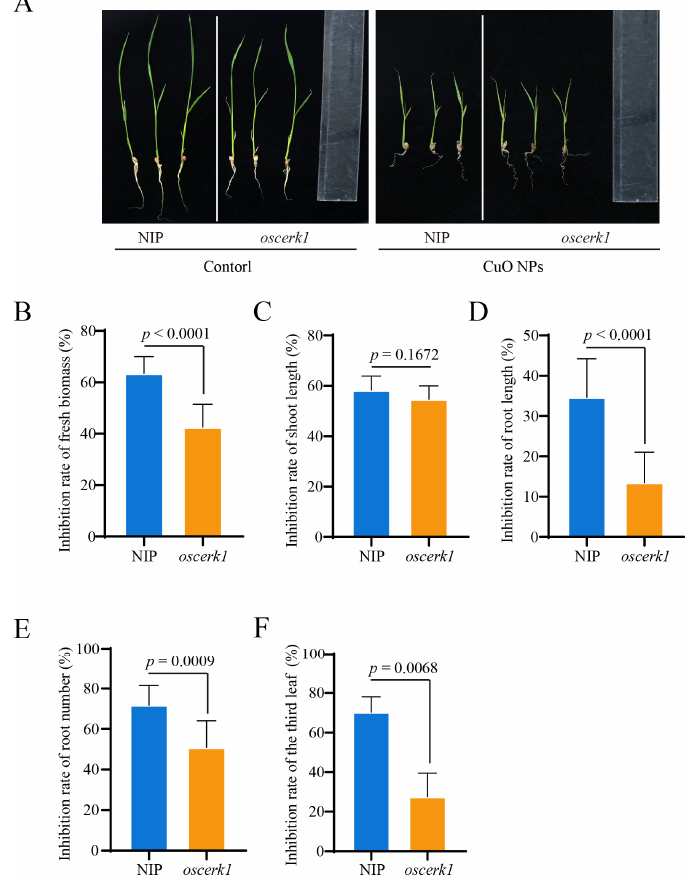
Figure 2. OsCERK1 regulates the tolerance of rice to CuO NPs stress. ( A ) The growth of the oscerk1 mutant and its wild-type Nipponbare (NIP) treated with CuO NPs for 14 days. The relative inhibition rates of fresh biomass ( B ), shoot length ( C ), root length ( D ), root numbers ( E ), and the third leaves’ length ( F ) of the oscerk1 mutants and its wild-type treated with CuO NPs for 14 days. The relative inhibition rate of fresh biomass was calculated based on the formula: inhibition rate (%) = [fresh biomass (control) − fresh biomass (CuO NPs)] / fresh biomass (control) × 100%. Similarly, the relative inhibition rates of shoot length, root length, root number, and the third leaf length were calculated according to the formula. The bars are shown as means ± SD of ten replications. The student’s t -test was used to analyze the data and generate a p